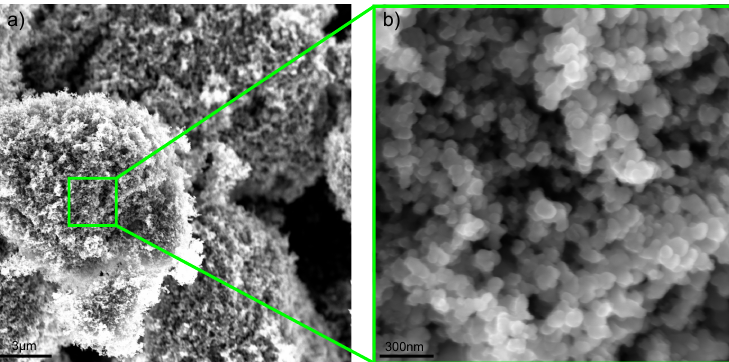
Figure A1. SEM images for PrintexL at magnifications of ( a ) 10k and ( b ) 150k.